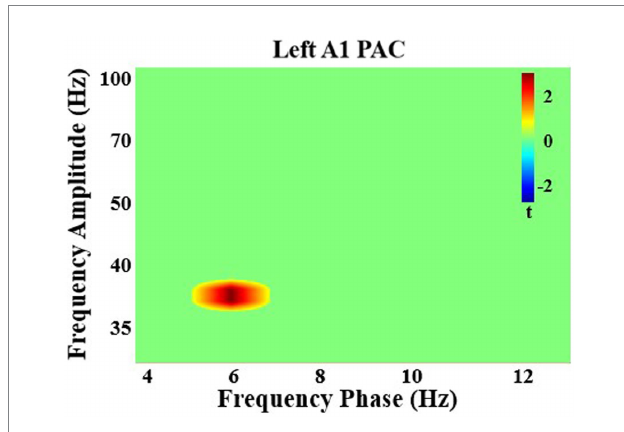
FIGURE 4 Significant phase-amplitude coupling analysis in left primary auditory cortex. There was a significant increase in coupling with attention between theta frequency phase and gamma frequency amplitude in left auditory cortex in all individuals.